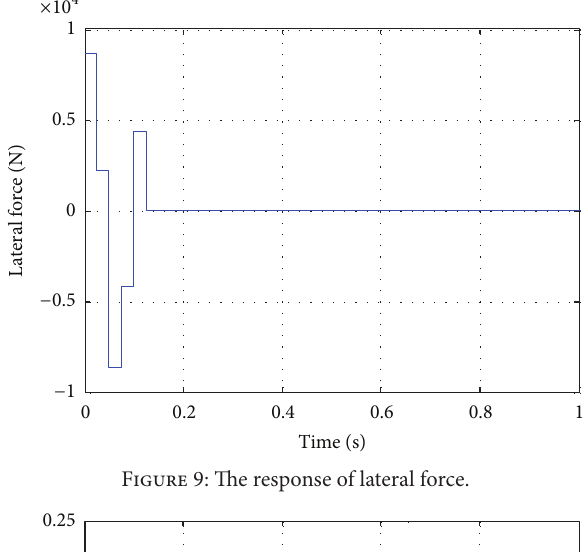
Figure 12: The response of lateral force.